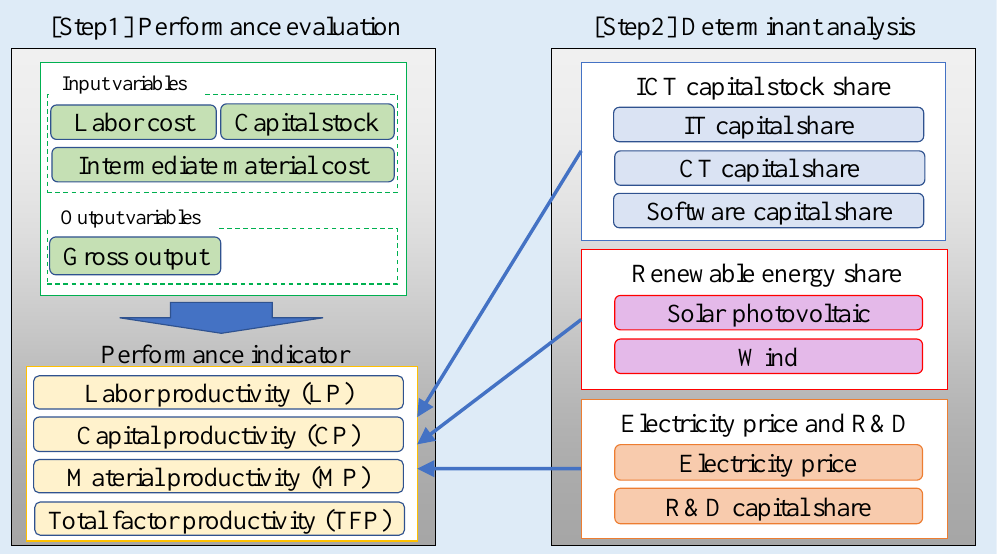
Figure 2. The research framework for this study.